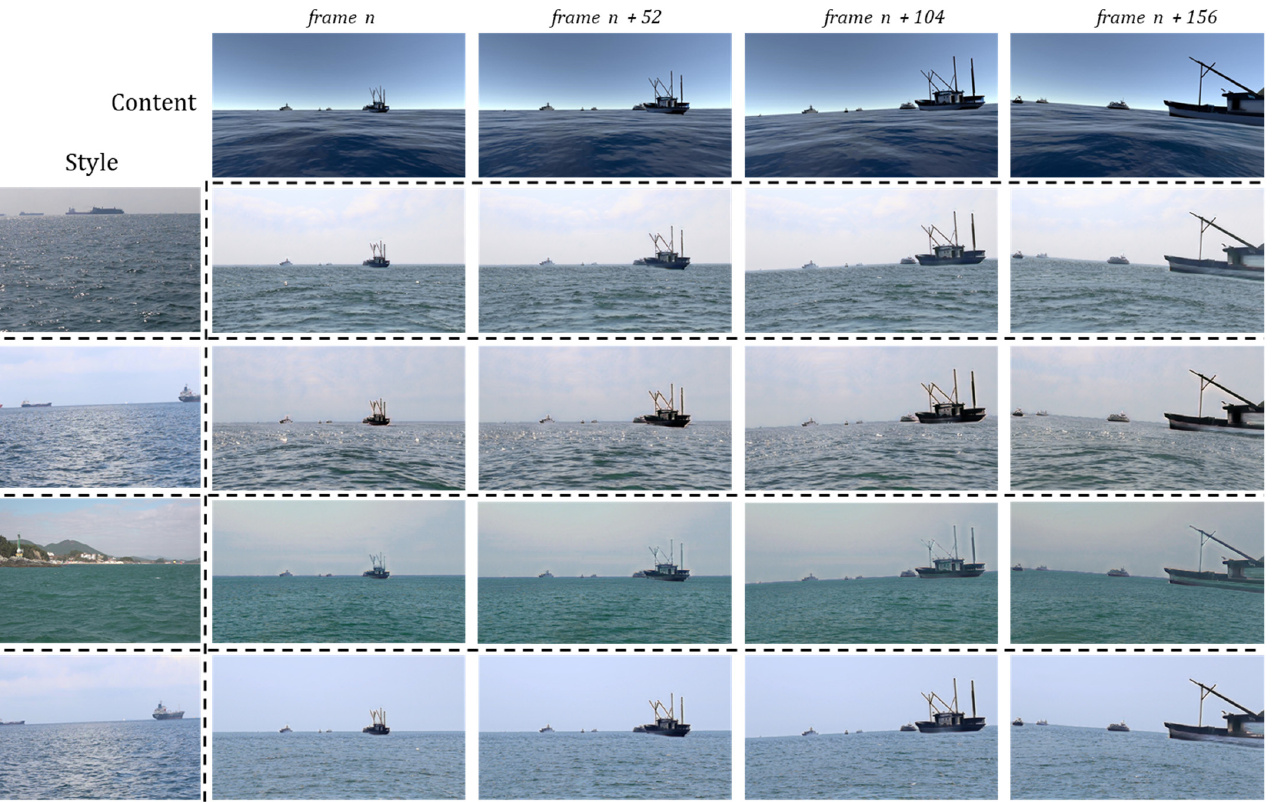
Figure 8. Compared results of four different style image mapping.